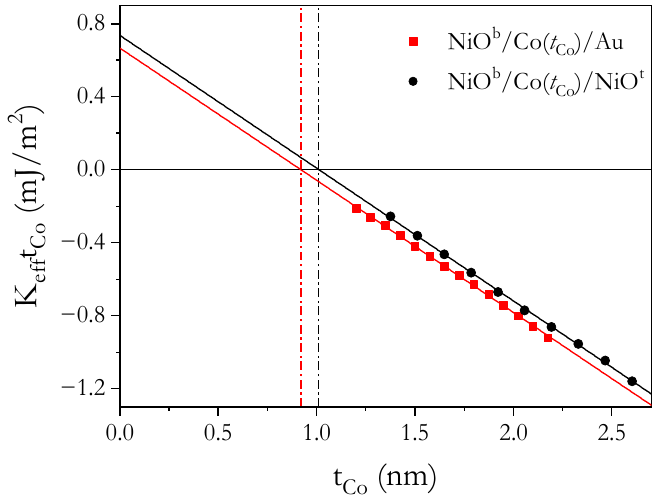
Figure 3. K eff t Co vs. t Co for NiO b /Co/Au and NiO b /Co/NiO t systems in the as-deposited state. The dashed lines indicate Co thickness corresponding to spin reorientation transition ( t SRT = − 2 K S / K V ).